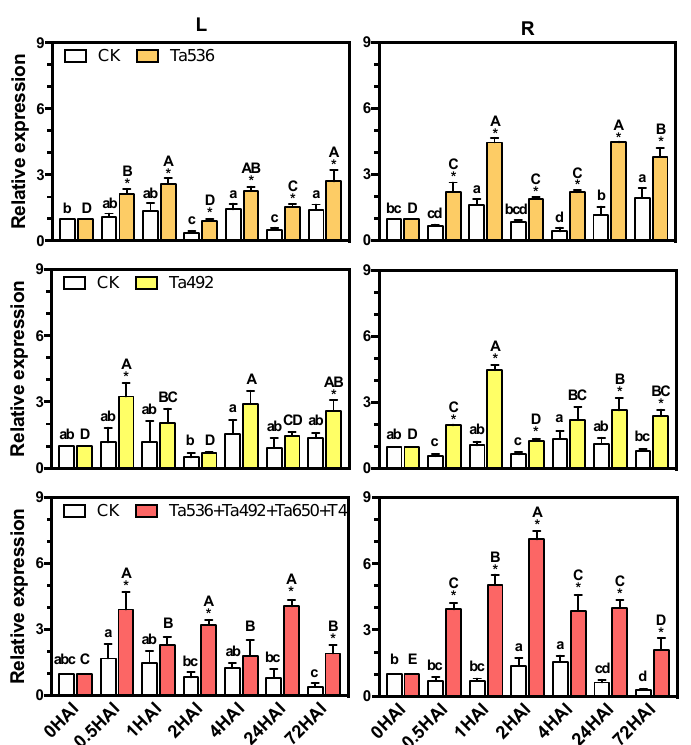
Figure 1. The expression of PdPapARF1 in response to the inoculation of di ff erent beneficial T. asperellum strains determined by q-RT-PCR. L, mature leaf. R, root. HAI, hour(s) after inoculation. Ta650, T. asperellum ACCC31650. T4, T. asperellum T4. Di ff erent capital letters represent significant di ff erences among the inoculated plant samples taken at di ff erent times (HAI); di ff erent lowercase letters represent significant di ff erences among the CK plant samples taken at di ff erent times; * significant di ff erence between inoculated and CK plants at the same time. All significances were at p < 0.05. All experiments were performed with three biological replicates with each replicate pooled of 10 plants and three technical replicates.